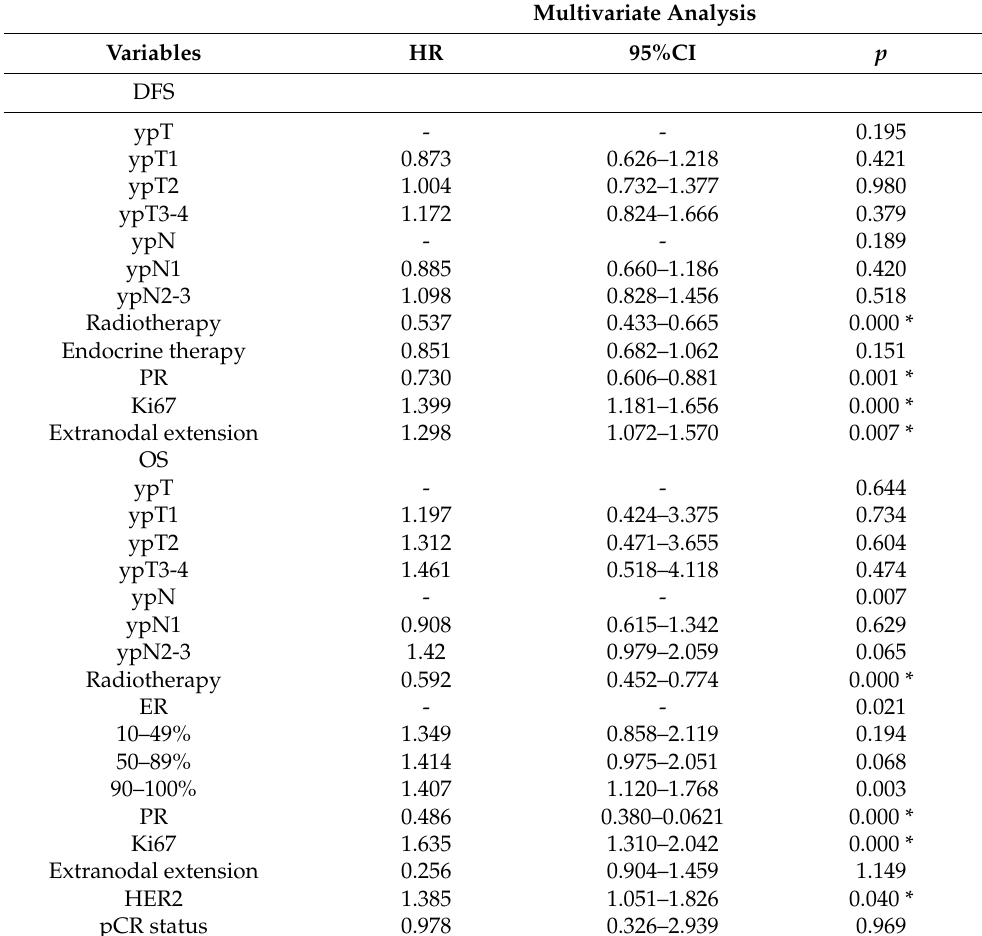
Table 2. Multivariate COX regression analysis of overall DFS and